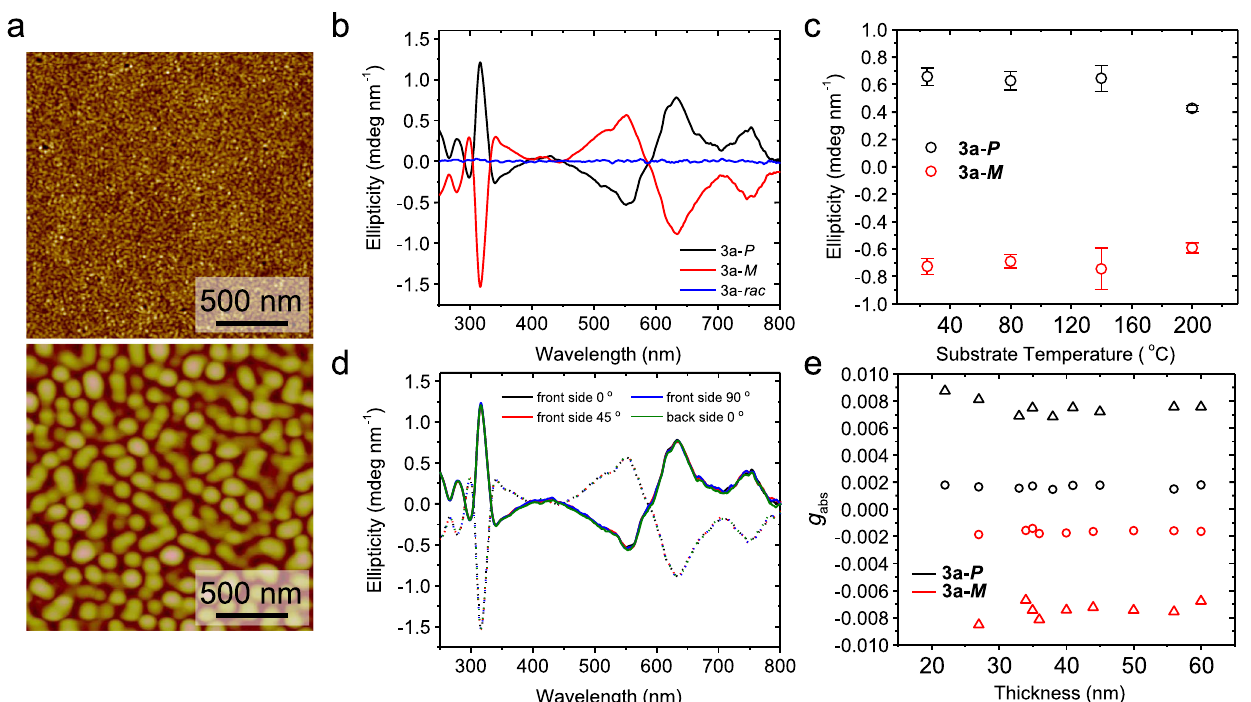
Fig. 3 Morphological chiroptical study of thin fi lm. a AFM topography images of 3a- P fi lms deposited at a substrate temperature of RT (top) and 140 °C (bottom). b Thickness normalized ellipticity of 3a thin fi lms deposited at 140 °C. c Thickness normalized ellipticity values at 635 nm for 3a- P / M thin fi lms prepared at different substrate temperature conditions. Error bars mean standard deviations. d Thickness normalized ellipticity of 3a- P / M thin fi lms deposited at 140 °C after sample fl ipping (back side) and sample rotation. Solid and dotted lines mean 3a- P and 3a- M , respectively. e Estimated g abs value of 3a- P / M thin fi lms evaporated at 140 °C. Circles and triangles mean g abs values at 740 and 635 nm,